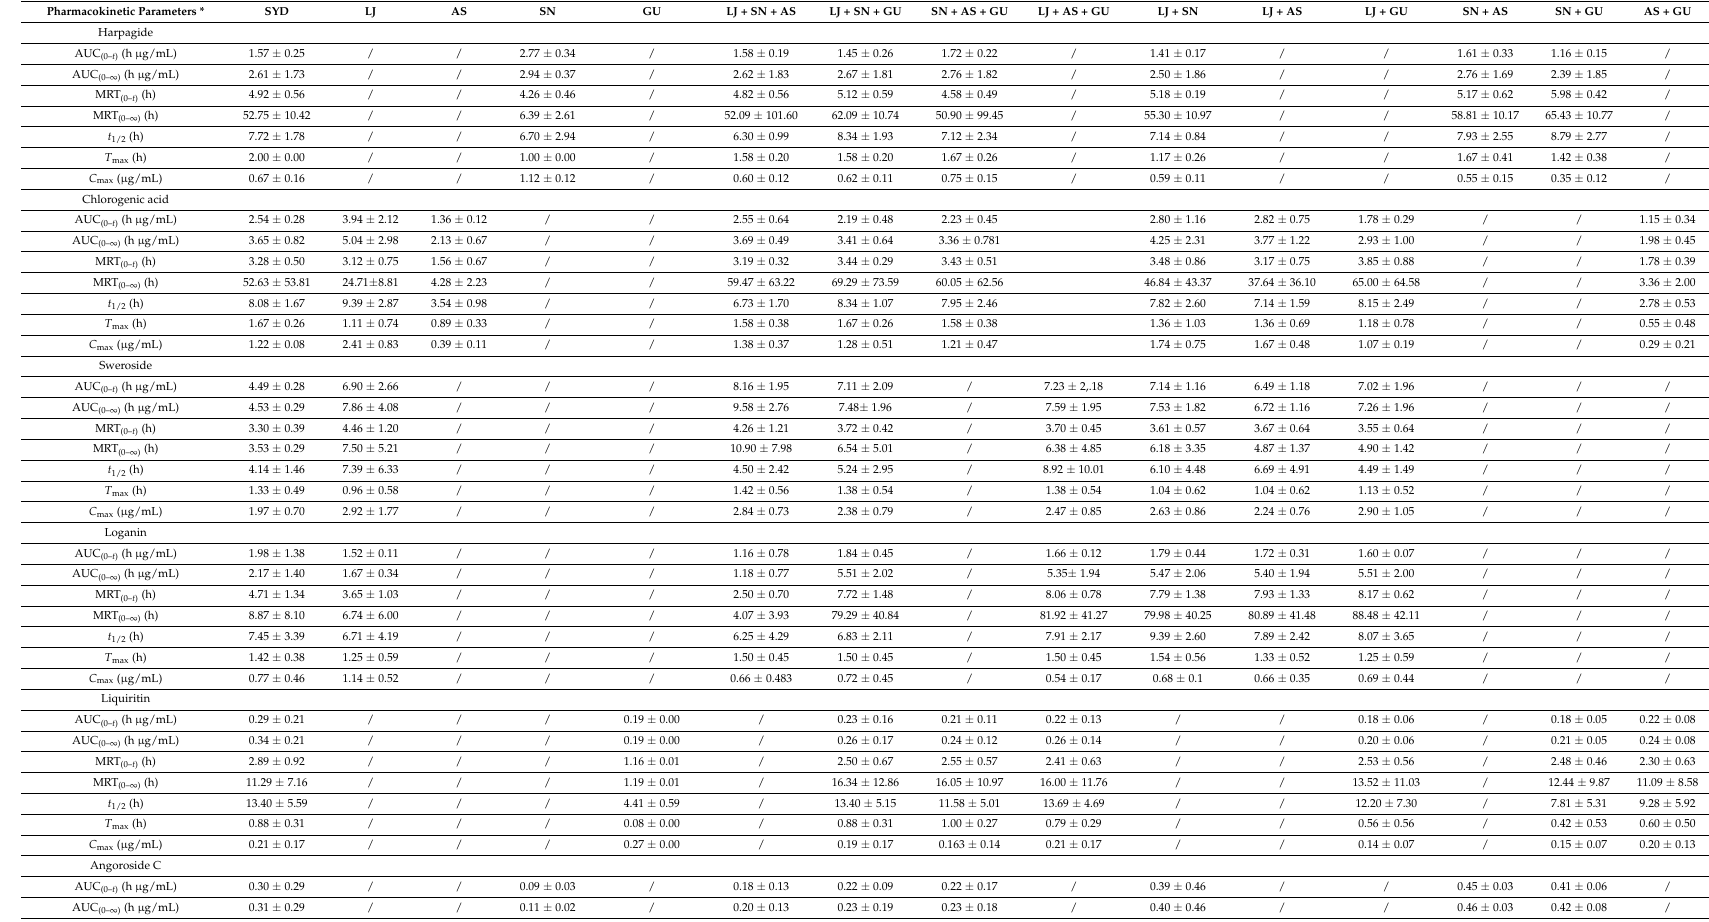
Table 3. Pharmacokinetic parameters of the seven compounds tested in plasma samples collected from rats orally administered fifteen compatibility combination extracts of SYD (mean ± SD, n = 6